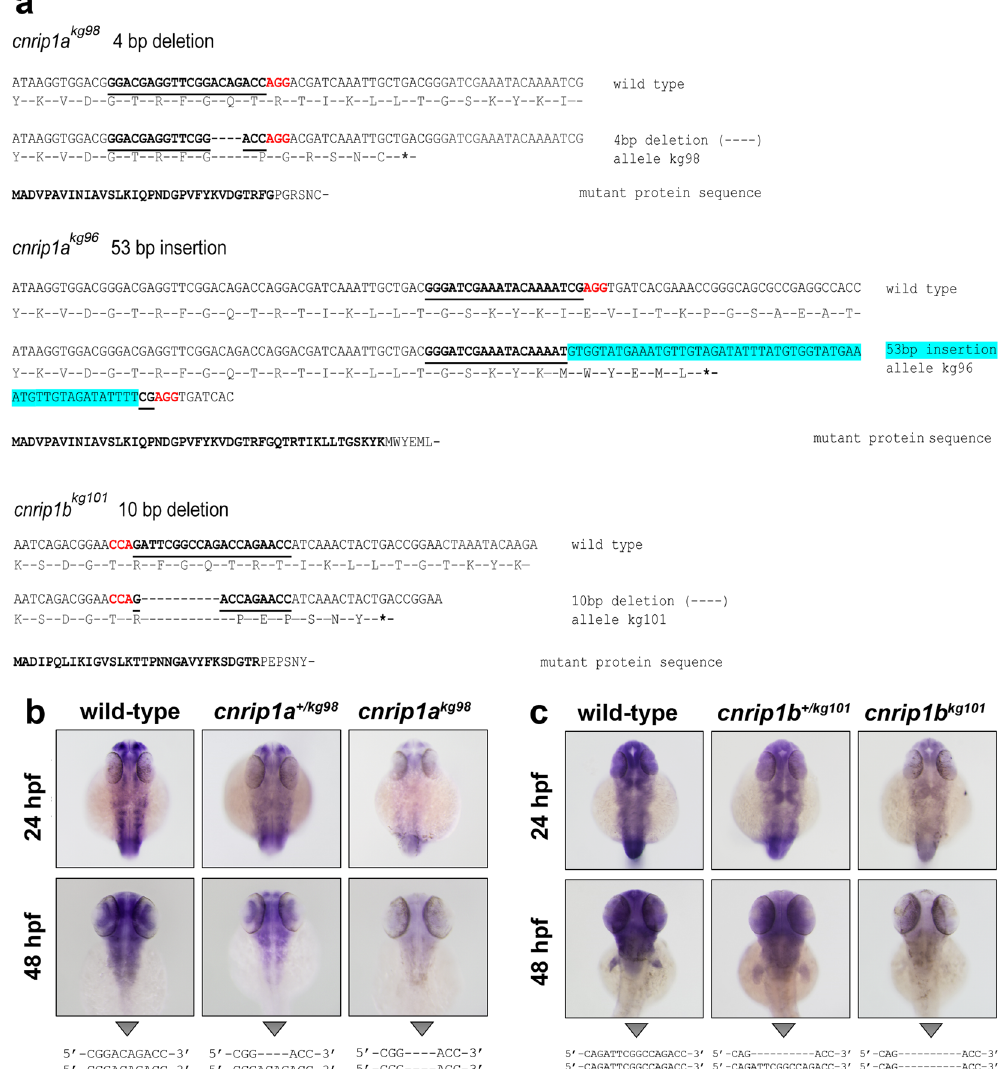
Figure 3. Mutagenesis of cnrip1a and cnrip1b . ( a ) Alignments of wild type with each of three mutant alleles showing the predicted expressed mutant polypeptide beneath. Bold underline indicates the gRNA target, red font the protospacer motif recognised by Cas9, hyphens deleted bases, blue highlight inserted bases and asterisks novel stop codons. In the mutant protein sequences, bold text indicates the residual wild type fragment and normal font the aberrant polypeptide tail. ( b , c ). To test for nonsense-mediated decay, about 50 siblings from in-crosses of cnrip1a + /kg98 ( b ) and cnrip1b + /kg101 ( c ) mutant carriers were subjected to in situ hybridisation for the cognate mRNA at the indicated stages, photographed, DNA extracted, PCR performed across the mutant locus and genotype confirmed by DNA sequencing as indicated beneath each panel. Quantitative evidence of reproducibility is given in Table